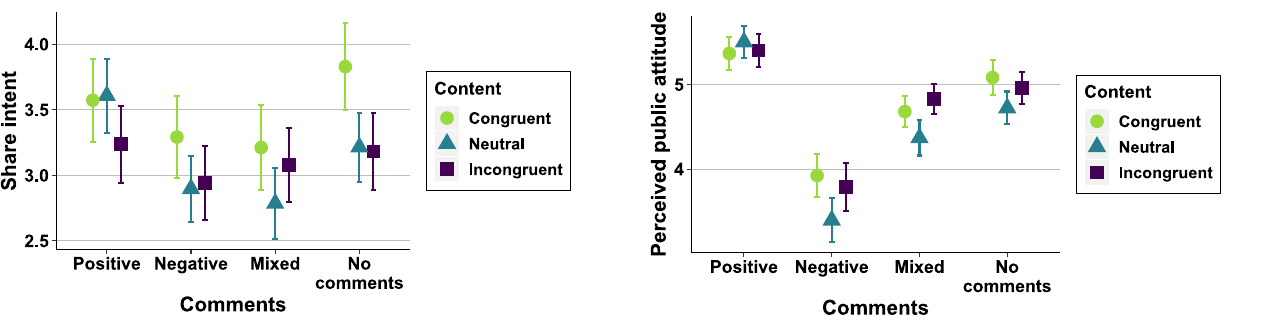
Fig. 5 Interaction effect of comment sentiment and article-content type on share intent . Error bars represent 95% CIs.